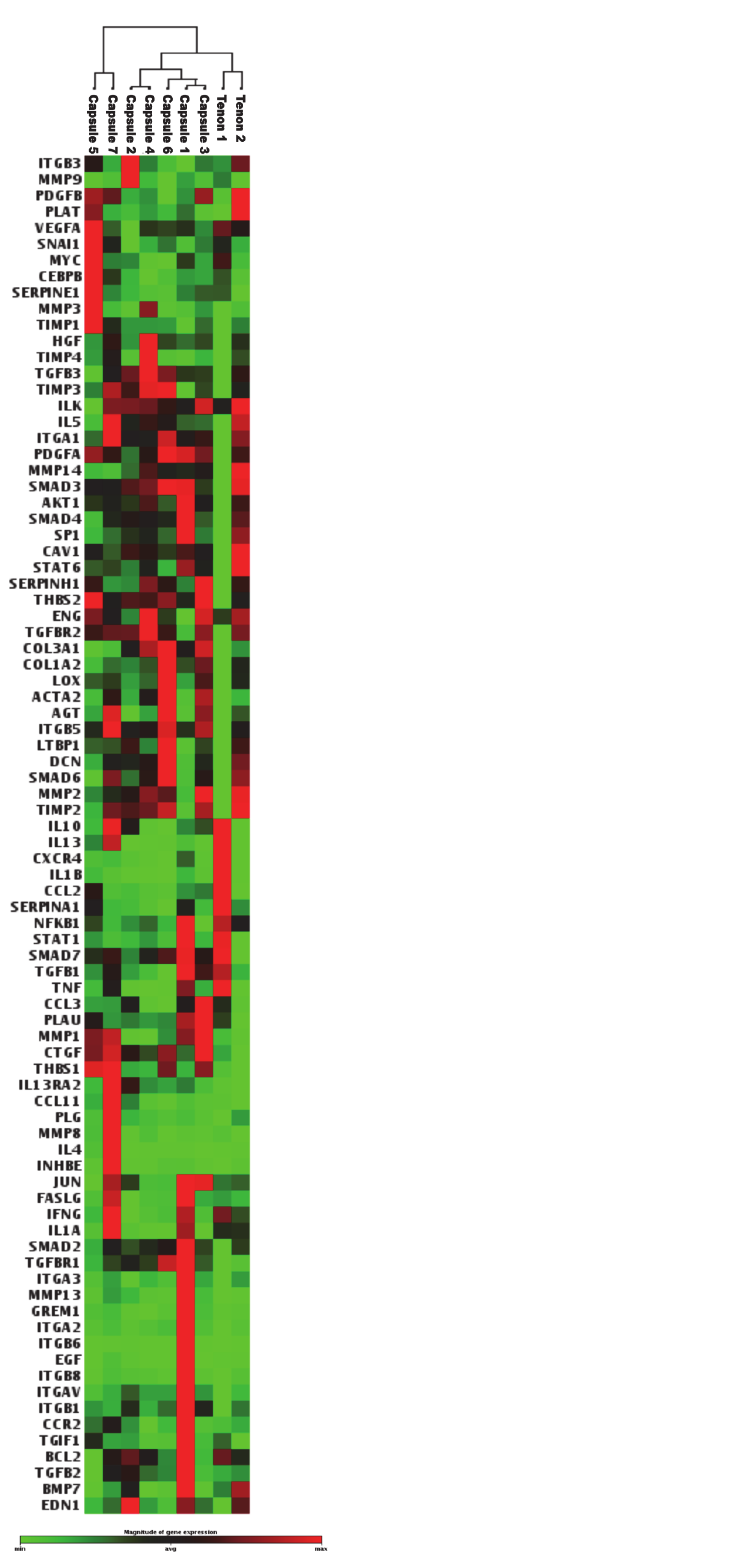
Fig 1. Non-supervised hierarchical clustering of normalized genes examined by PCR analysis.